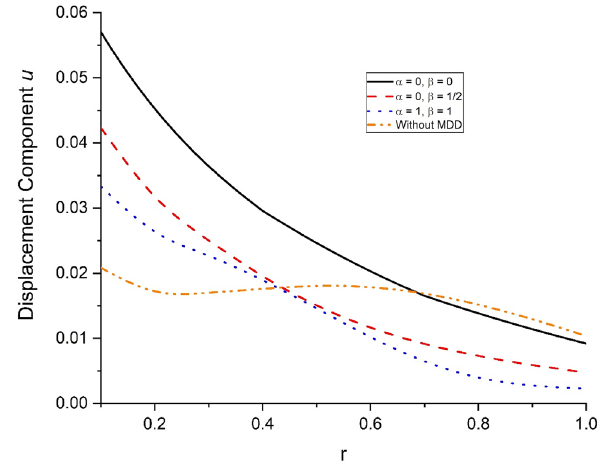
Fig. 1 Variations of displacement component u with radius r